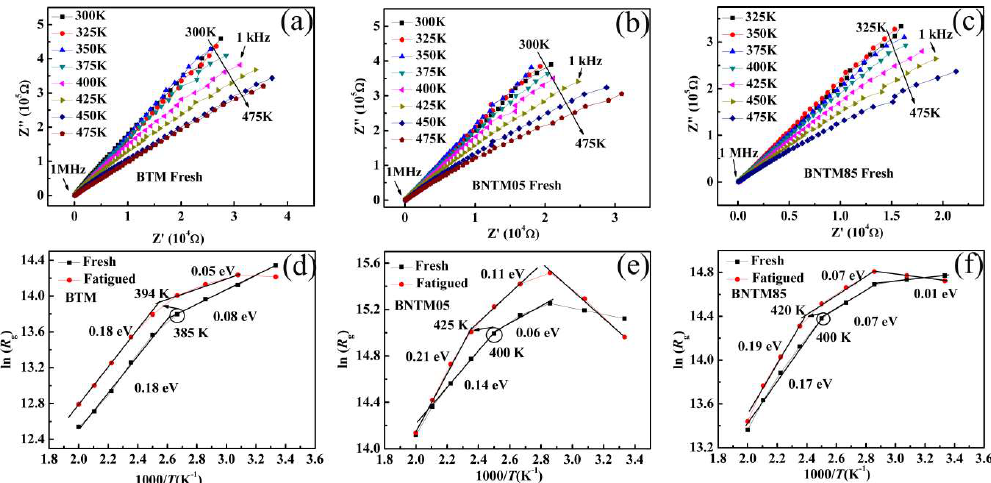
Figure. 5. Impedance diagrams at elevated temperature and ln( R g ) vs. 1000/ T Arrhenius plots at both fresh and fatigued condition: ( a , d ) for BTM; ( b , e ) for BNTM05; ( c , f ) for BNTM85.